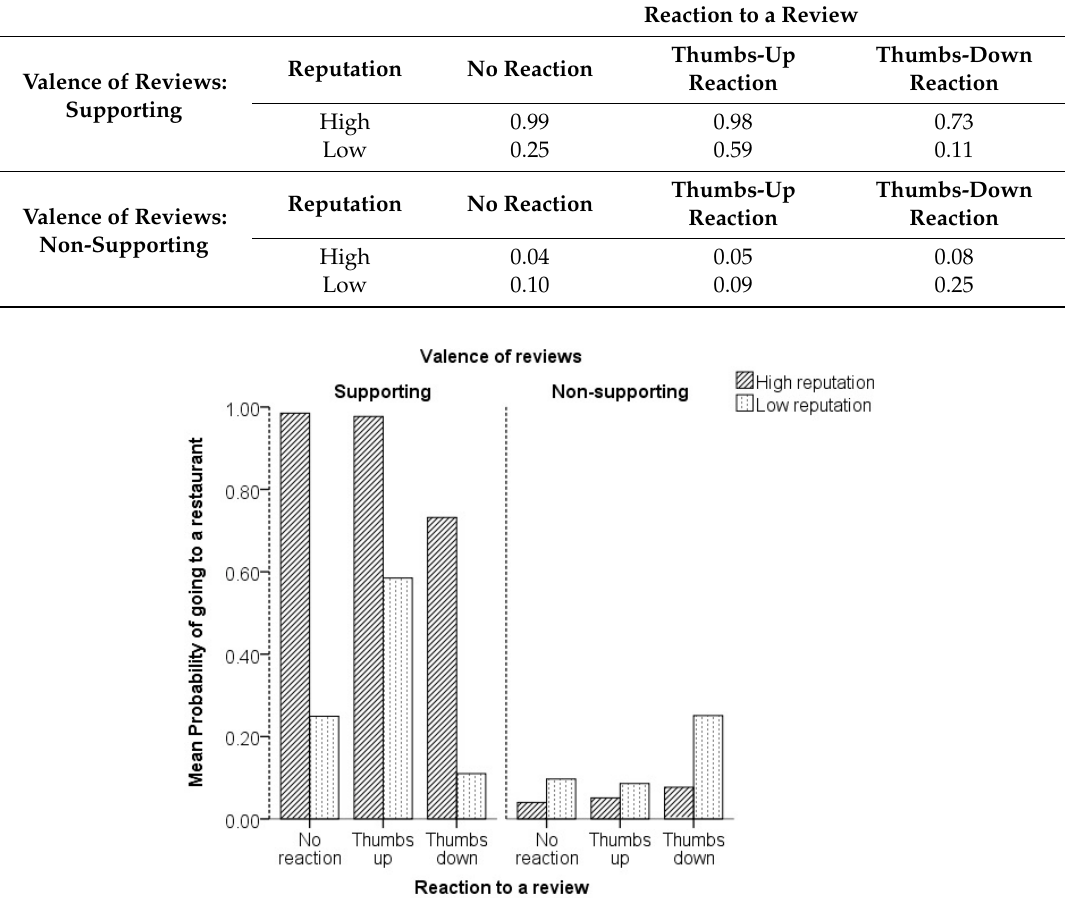
Figure 8. Effect of reaction to a review, reputation score and valence of reviews on mean